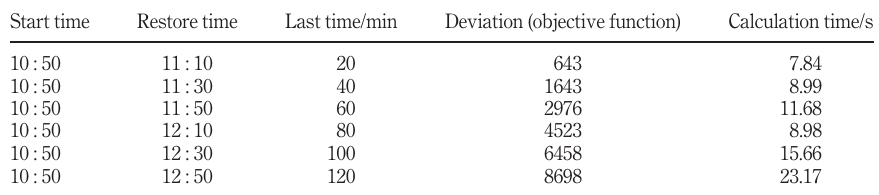
Table 5. Scenario 2 results